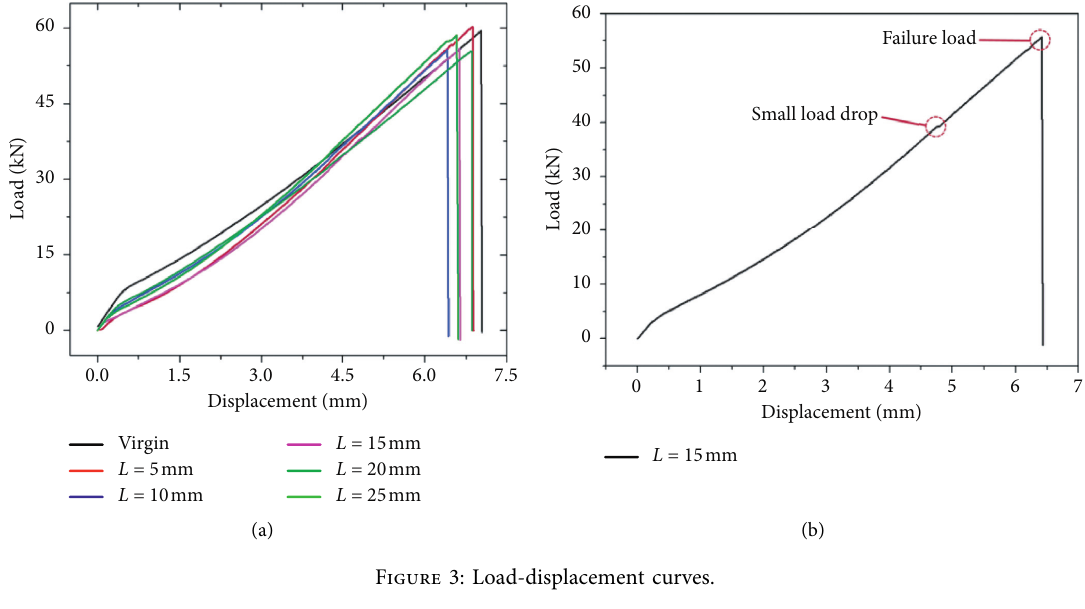
Figure 3: Load-displacement curves.